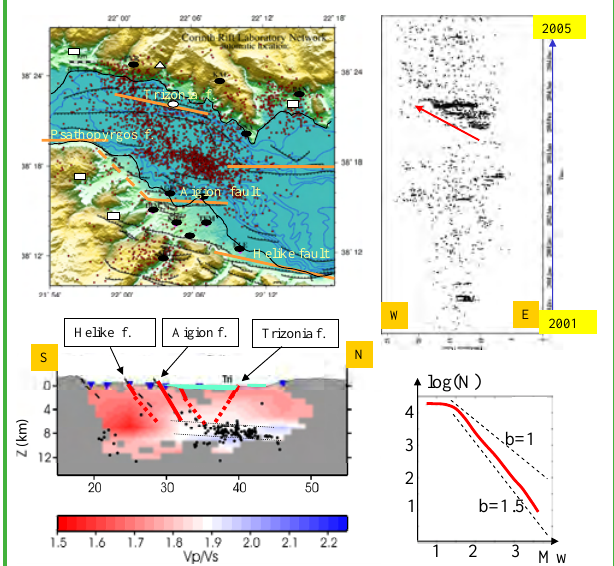
Figure 2. Seismicity at CRL. Top left: seismicity map 2000–2005, from au- tomatic picking of CRL stations (black ovals). white oval: Trizonia STS2 sta- tion with real-time satellite telemetry. white triangle: broad band Czeck seis- mometer. white squares: broad band seismometers with real-time telemetry, planned summer 2006. orange lines: outcrop of main presently active normal faults. Top right: Time-space evolution of seismicity from 2000 to 2005 on an ESE-WNW axis. red arrow: migration of seismicity possibly linked with water diffusion (Cornet and Bourouis, and CRL Team, 2005). Bottom left: Vp/Vs ratio and 2000–2005 seismicity. red lines: major active faults (Gautier et al., 2006). Bottom right: red curve: Gutenberg-Richter law for the 2000–2005 period, with moment magnitude